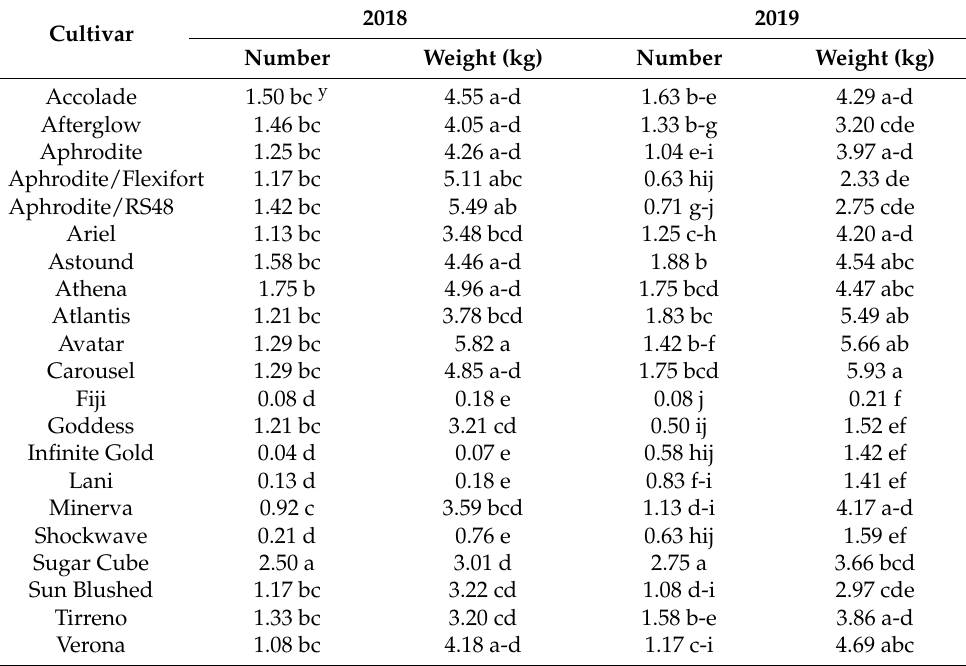
Table 7. Mean marketable number z and weight per plant of 20 muskmelon cultivars and two grafted entries evaluated in southeastern Pennsylvania in 2018 and 2019.